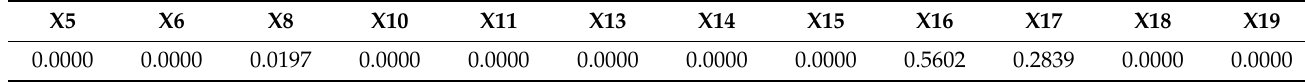
Table 7. The p -values obtained from the Fisher test.